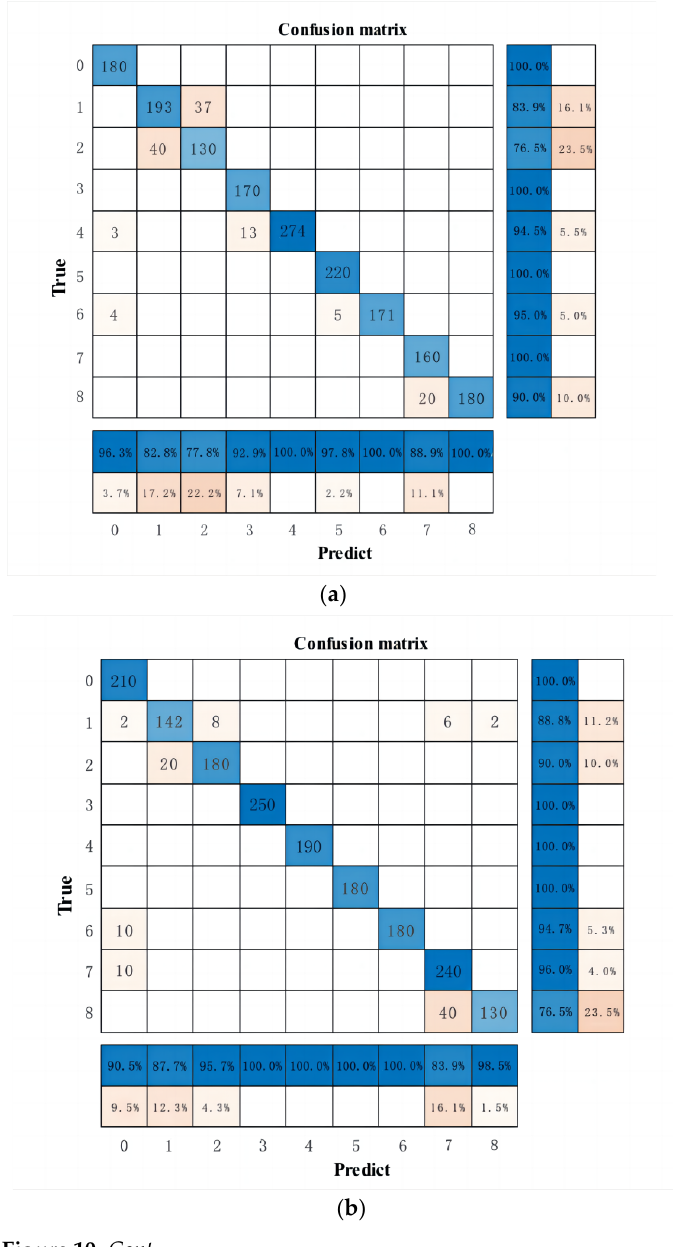
( c ) Figure 10. Confusion matrix of the testing dataset. ( a ) Confusion matrix of testing dataset for the LSTM neural network, ( b ) Confusion matrix of testing dataset for the CNN-LSTM model, and ( c ) Confusion matrix of testing dataset for the SSA-CNN-LSTM model. Select metrics based on the confusion matrix of the testing dataset classification were used. Precision and Recall are used to compare the diagnosis results of different methods. Precision P and recall R can be expressed as shown in Formulas (13) and (14): TP P TP FP =